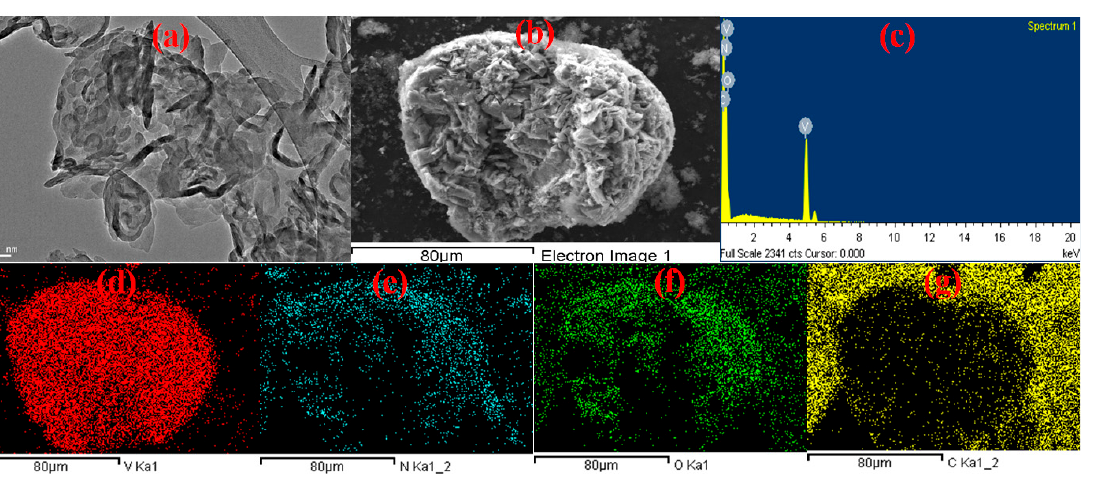
Figure 1. ( a ) TEM image, ( b ) SEM image, ( c ) EDX, and ( d – g ) elemental mapping of the V 2 O 5 -g-C 3 N 4